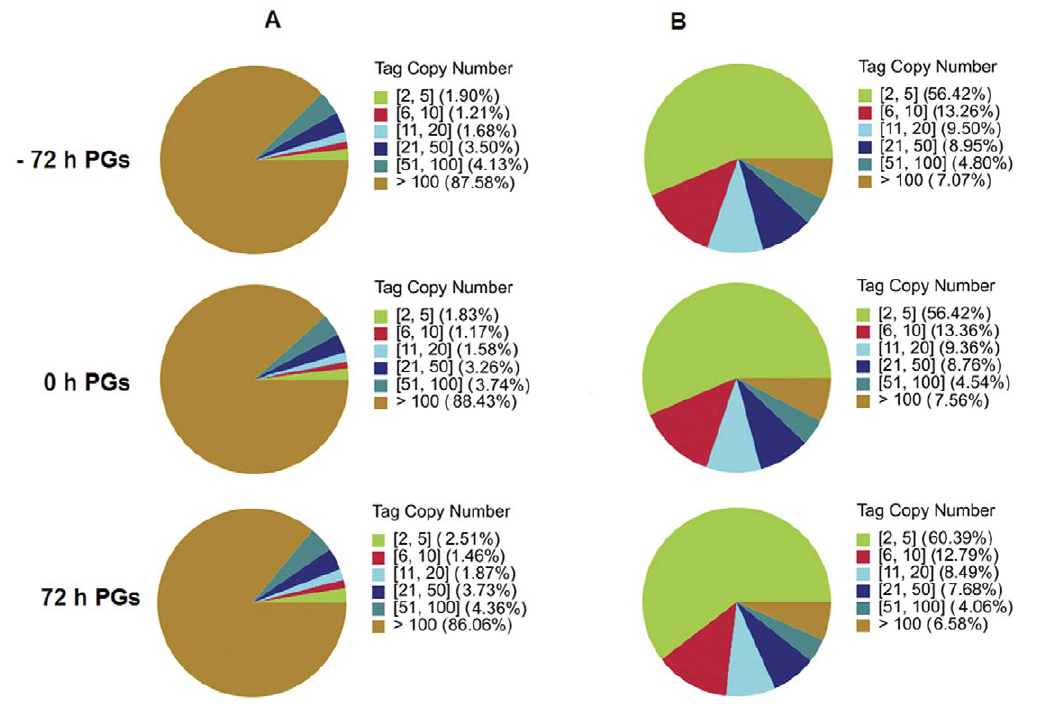
Figure 2. Distribution of total clean tags and distinct clean tags in each library. A: Distribution of total clean tags. B: Distribution of distinct clean tags.